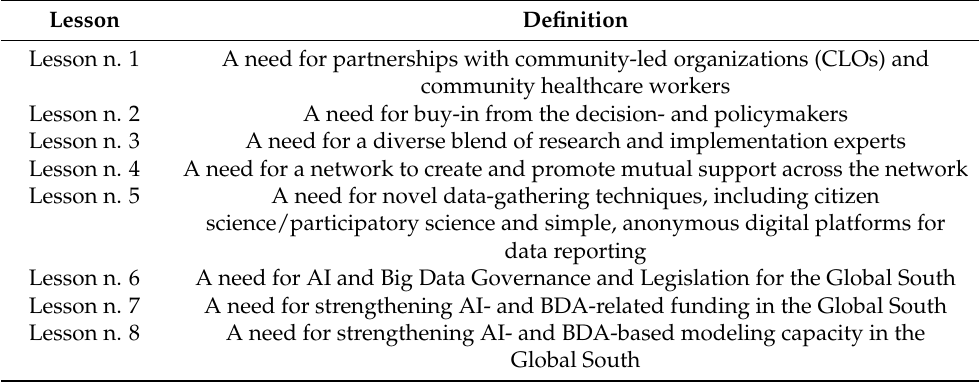
Table 4. The results of the qualitative analysis, which has enabled the identification of the lessons learned from the ACADIC Project in the Global